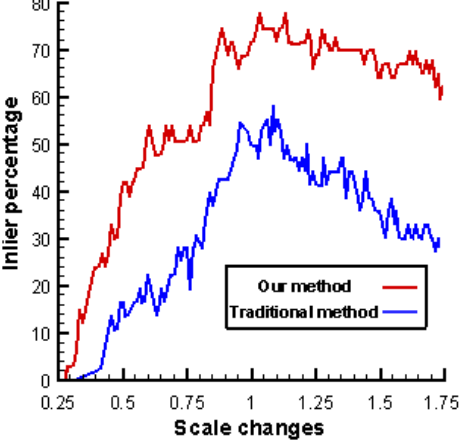
Figure 2. Influence of the proposed